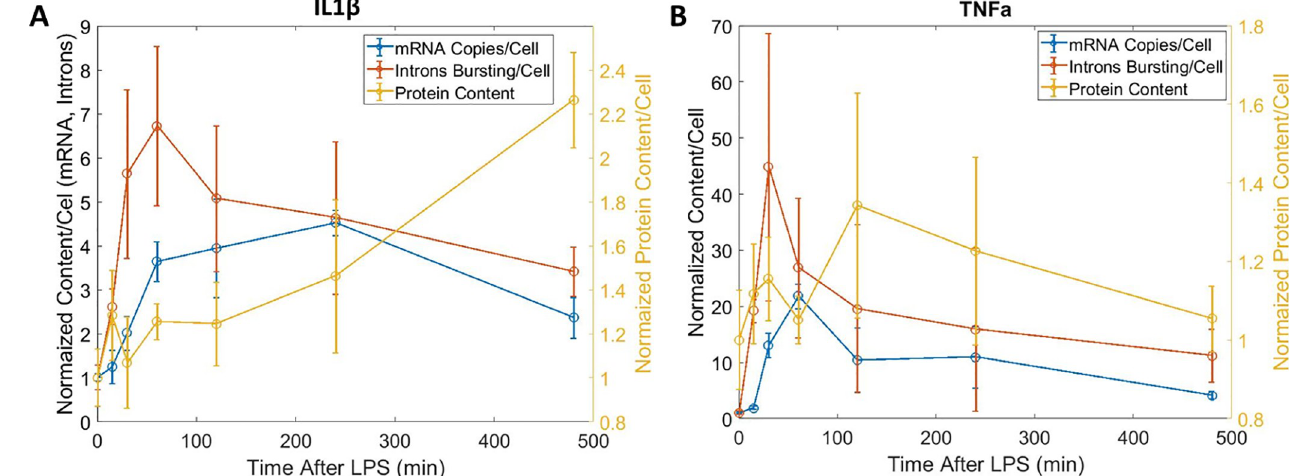
Fig 4. Mean mRNA, intron bursting site, and protein content for IL1 β (A) and TNF α (B) over time.